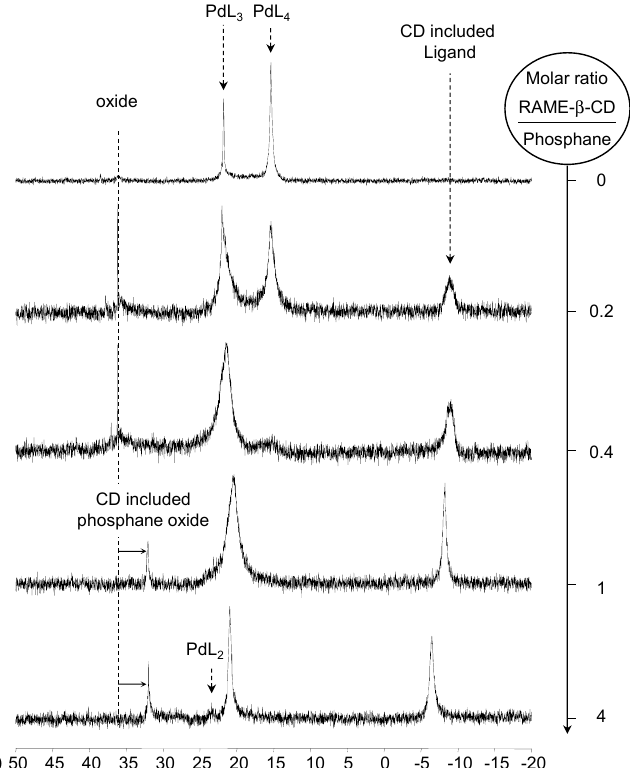
Figure 14. 31 P{ 1 H} NMR spectra effect of RAME- β -CD quantity on the equilibrium of the different palladium species formed with the ligand P(Biph) 3 TS in D 2 O at 25 °C with a ligand concentration of 66 mM.